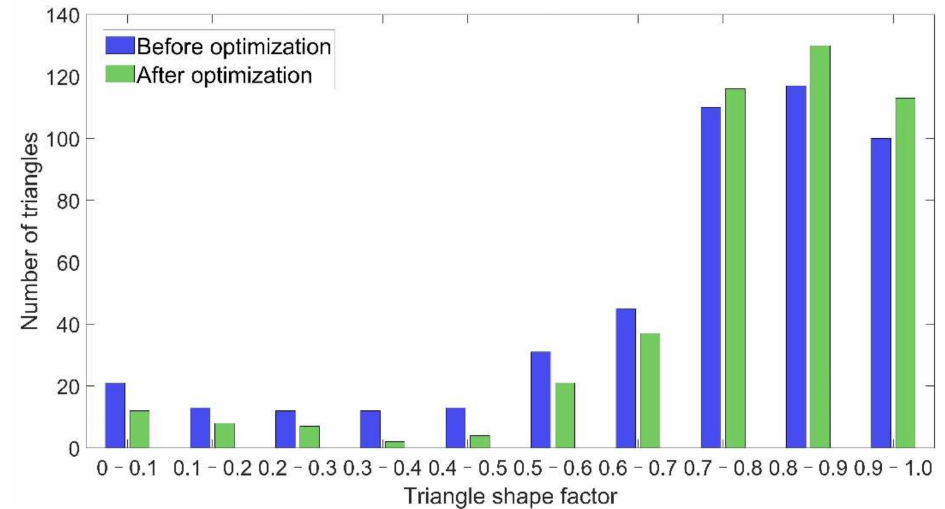
Figure 15. Comparison of triangle shape factor distribution before and after unstructured mesh optimization in a small area of